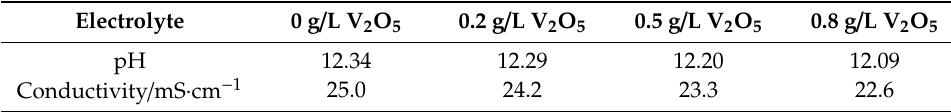
Table 1. The pH values and conductivity of the electrolytes.